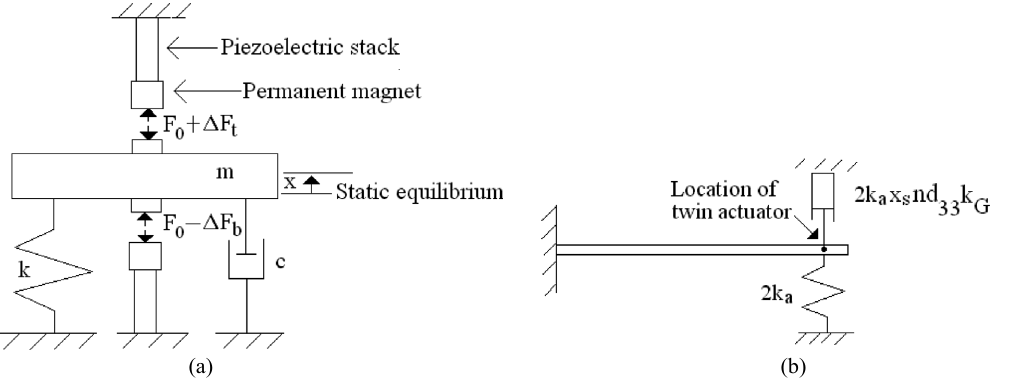
Fig. 5. (a). A single degree of freedom (SDOF) system with the proposed actuator; (b). Linear model of a beam with twin